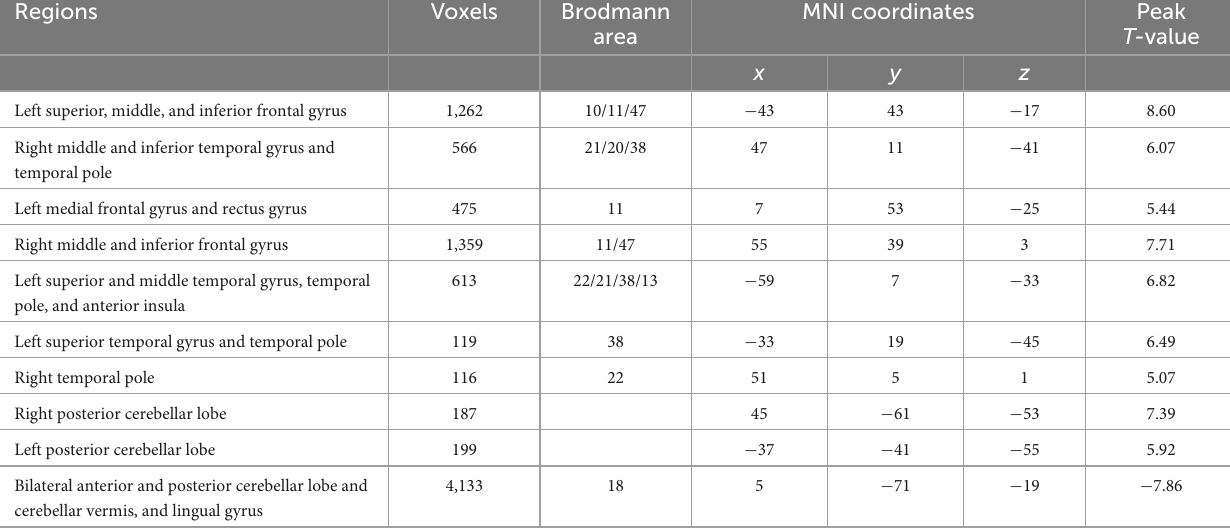
TABLE 1 Differences in isotropic volume fraction between the rested wakefulness and sleep deprivation. Regions Voxels Brodmann